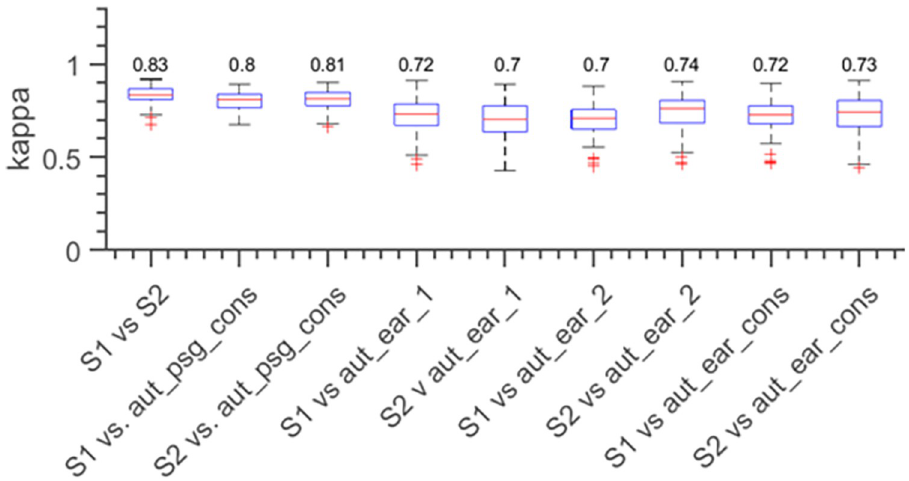
Fig 3. Box-plots showing the agreement (Cohen’s kappa) between different scorers and classifiers. The first column ‘S1 vs S2’ shows the statistics for scorer1 vs scorer2. The second and third column ‘S1 vs aut_psg_cons’ and ‘S2 vs aut_psg_cons’ shows the statistics for scorer1 and scorer2 vs the automatic PSG-based sleep scoring trained on the consensus epochs. The fourth to the seventh column shows the statistics for a manual PSG-based scoring vs an automatic ear-EEG based scoring; e.g. ‘S1 vs aut_ear_1’ is the statistics for scorer1 vs the scoring from the automatic ear-EEG sleep scoring algorithm trained on labels from scorer1. The last two columns show the statistics for scorer1 and scorer2 vs an automatic ear-EEG based scoring trained on consensus